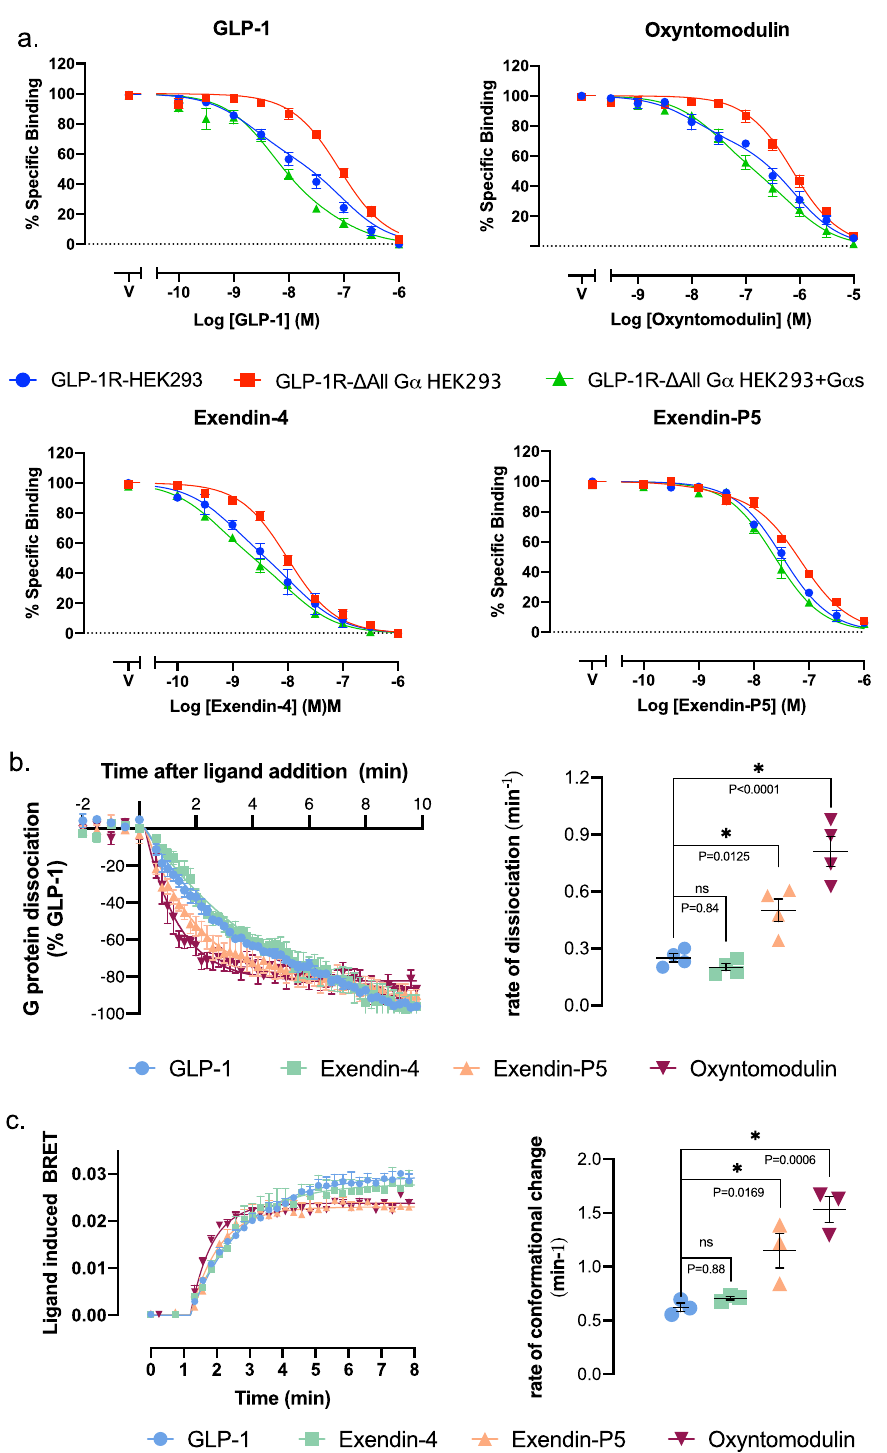
(Fig. 7c), suggesting a different ensemble of conformations of the AHD relative to the RHD, when bound by the different agonists. GLP-1R interactions with G s are conserved, however, MD simulations reveal ligand-speci fi c effects on interaction dynamics . Overlay of the four consensus cryo-EM static